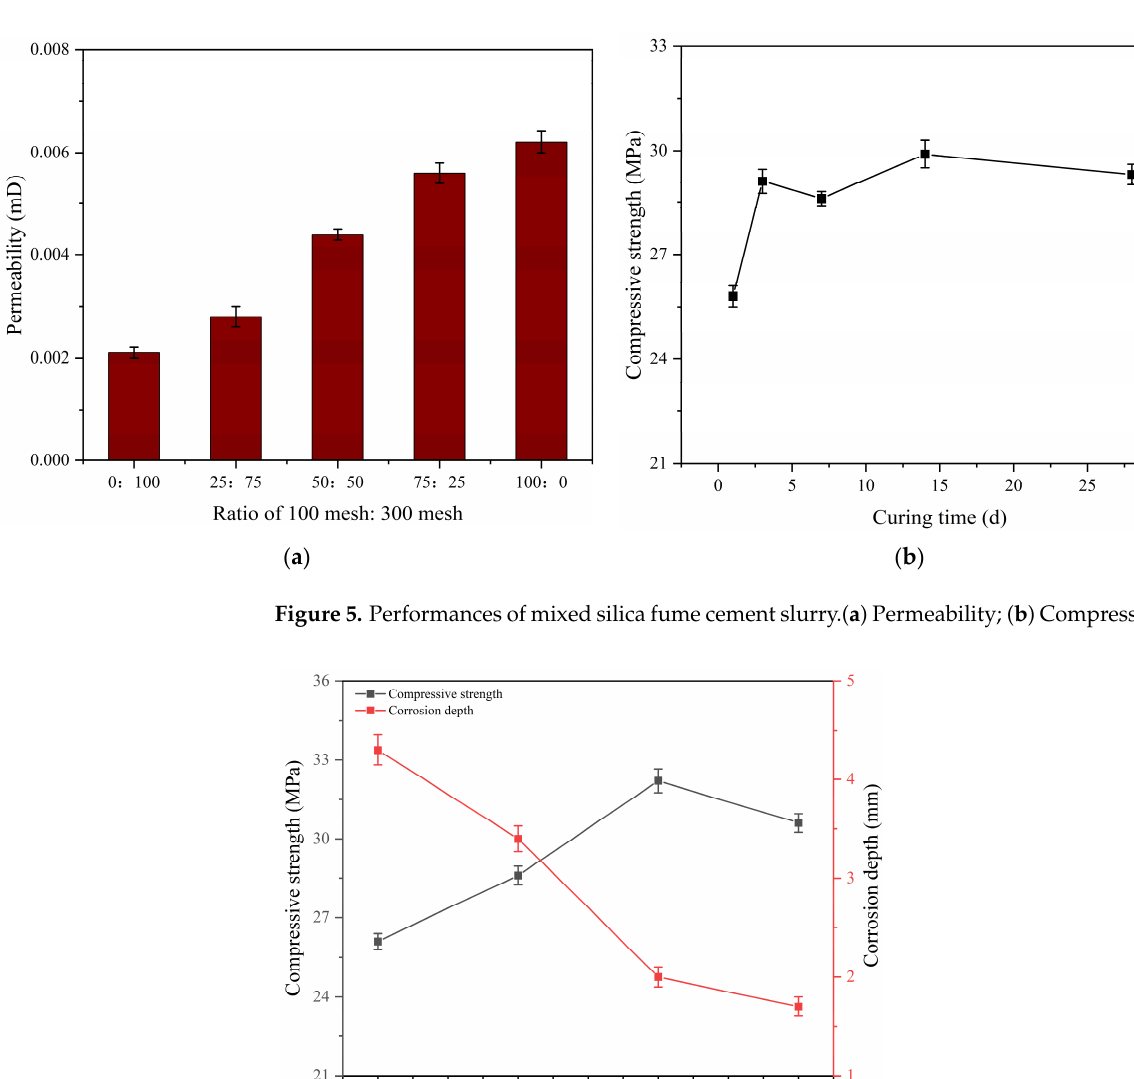
Figure 5. Performances of mixed silica fume cement slurry.( a ) Permeability; ( b ) Compressive strength.